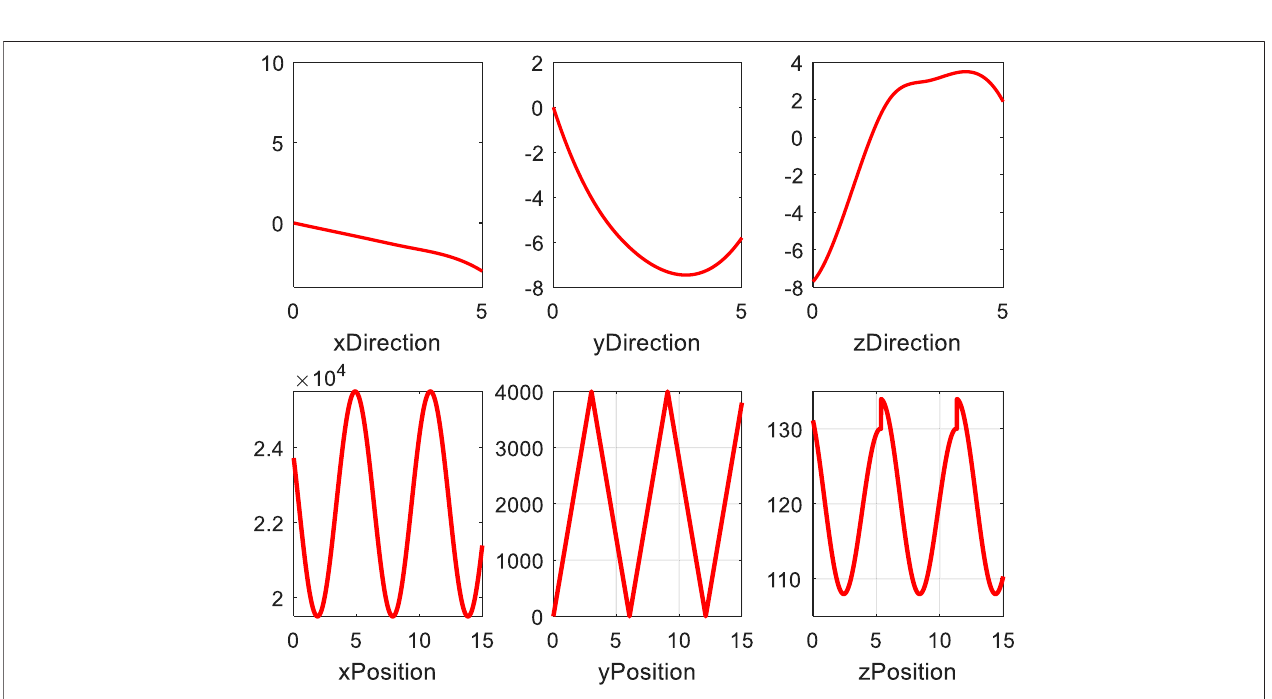
FIGURE 8 | End position and angle of the bio-inspired mobile manipulator under synchronous sensing.